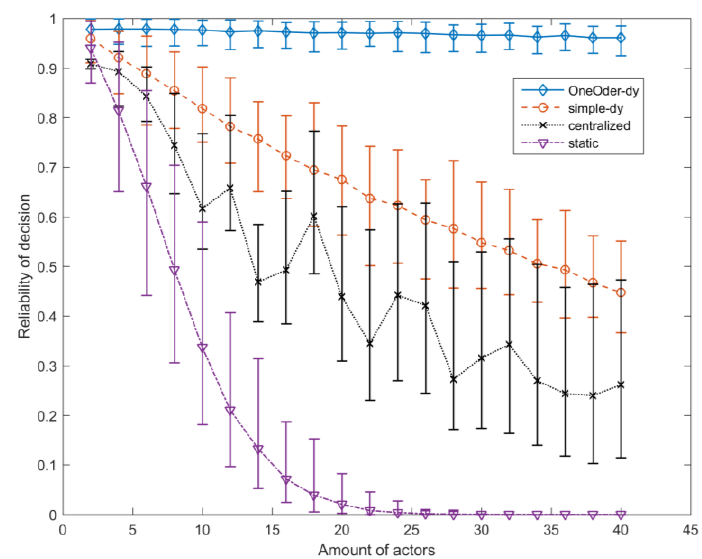
24 of 33 Table 4. Robustness on reliability of four strategies. Mean